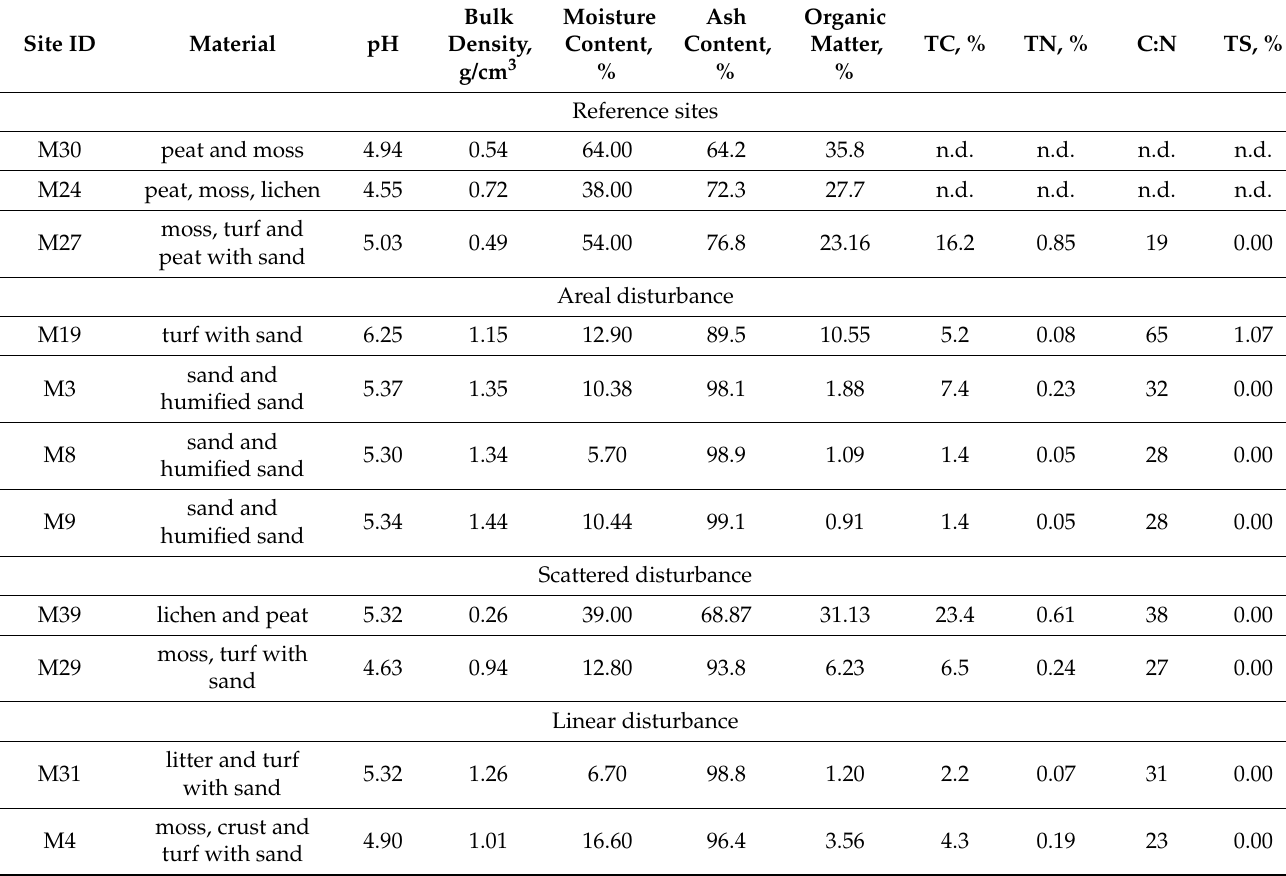
Table 3. Physicochemical parameters of the topsoil material in the studied sites.